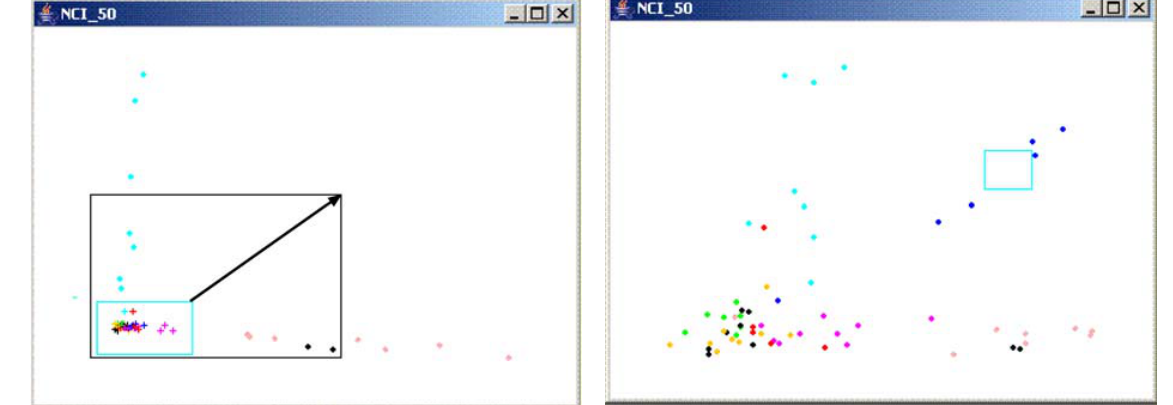
Figure 3.4: Prototype Tool Interface: the user successfully separates the chosen cluster of